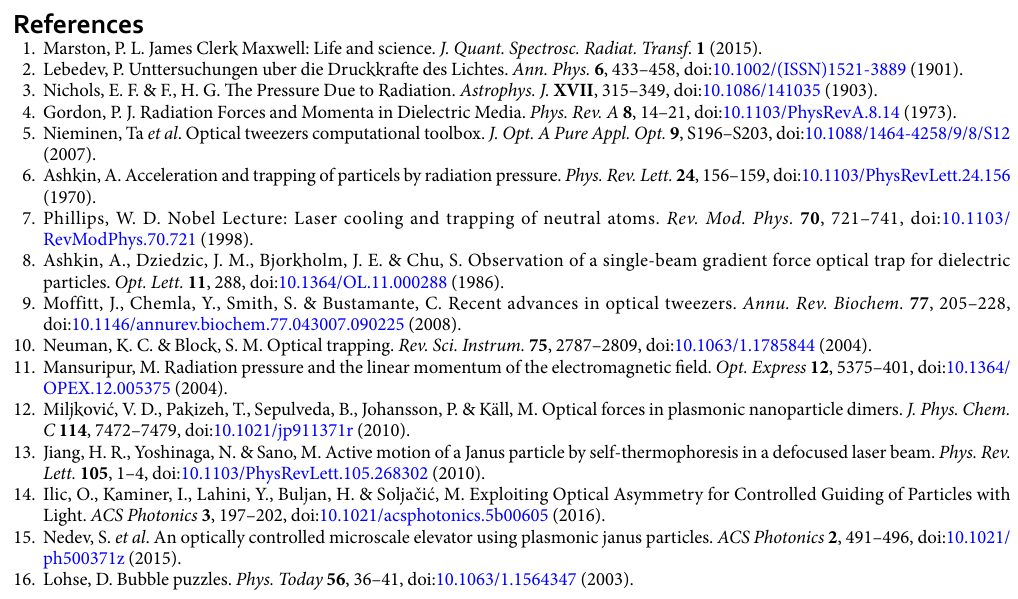
spheres. More details are given in the supplementary data file. High frame rate imaging. Different cameras were used throughout the experiments. Figure 1 was captured with a standard CMOS camera (DCC1545M from Thorlabs, USA). The images in Fig. 2 were taken with a high speed camera Phantom v12.1 from Vison Research USA. Each frame comprised of 128 × 32 pixels which allowed for a rate of 500,000 frames per second at exposure of 1.8 μ s (2 μ s between each frame). The images shown in Fig. 2 were acquired without the spacer between slides for a more crisp view of the spheres motion that was somewhat suppressed in-turn. See supplementary data for more details. Simulation.